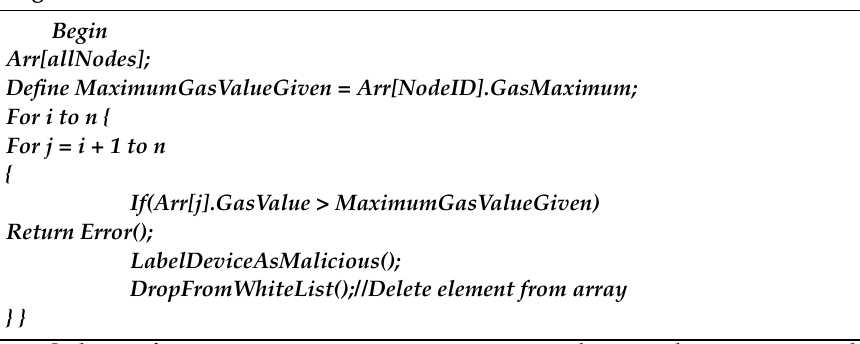
Algorithm 8: Check Gas Limit Value